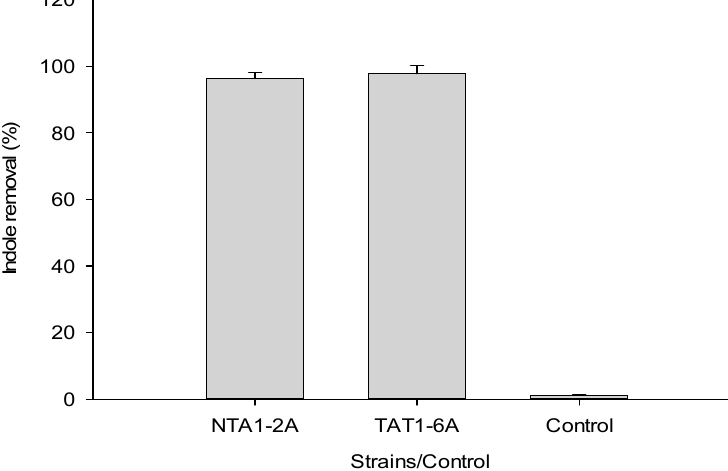
Figure 7. Indole removal test by extract or supernatant fluid obtained from medium cultures of NTA1-2A and TAT1-6A. Error bars: Mean ± SE of three replicates.